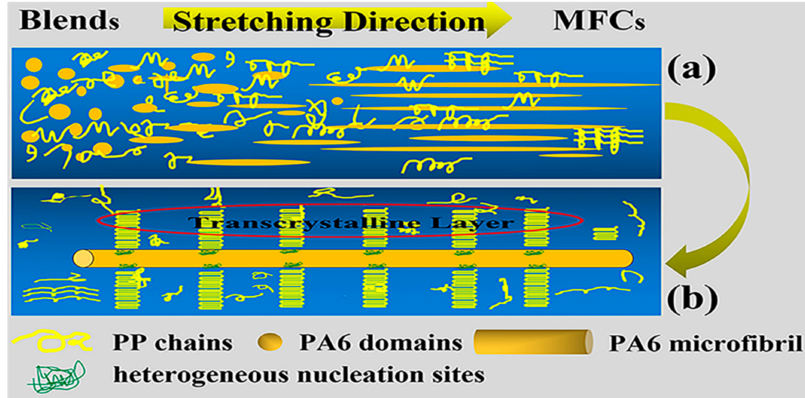
Figure 7. A schematic diagram for ( a ) the evolution of the phase morphology and ( b ) the internal structure of the PP / PA6 microfibrilar composites